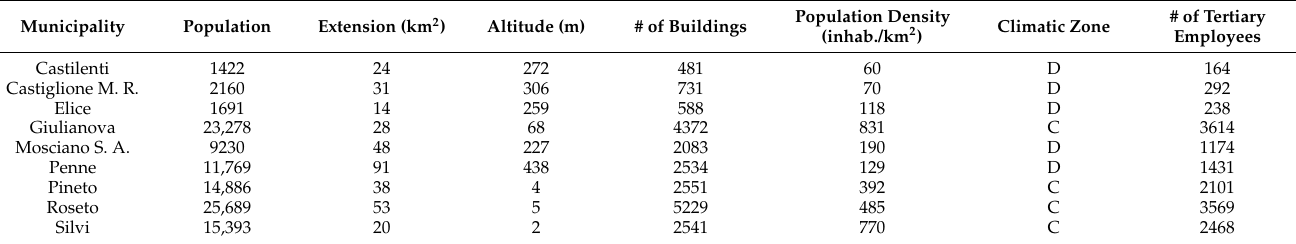
Figure 2. Area of study: nine municipalities in the provinces of Teramo and Pescara in the Abruzzo region. Table 5. Geographical and social information on the nine municipalities.